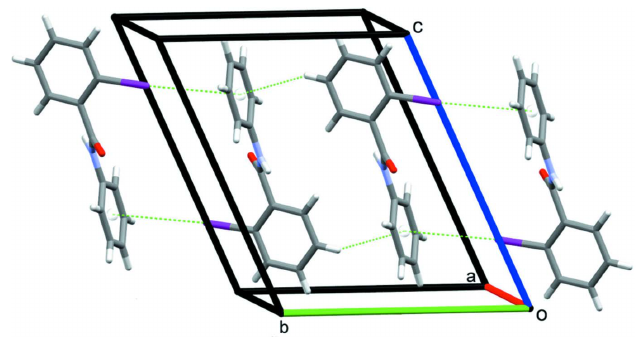
Figure 6 C—I (cid:2)(cid:2)(cid:2) (cid:2) (ring) and C—H (cid:2)(cid:2)(cid:2) (cid:2) (ring) contacts generating sheets of mol- ecules of (II) along the ab diagonal